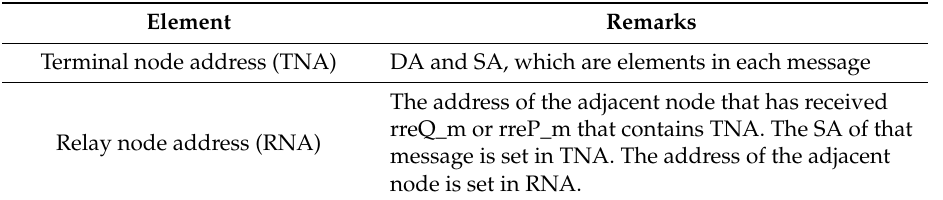
Table 5. Structure of a routing